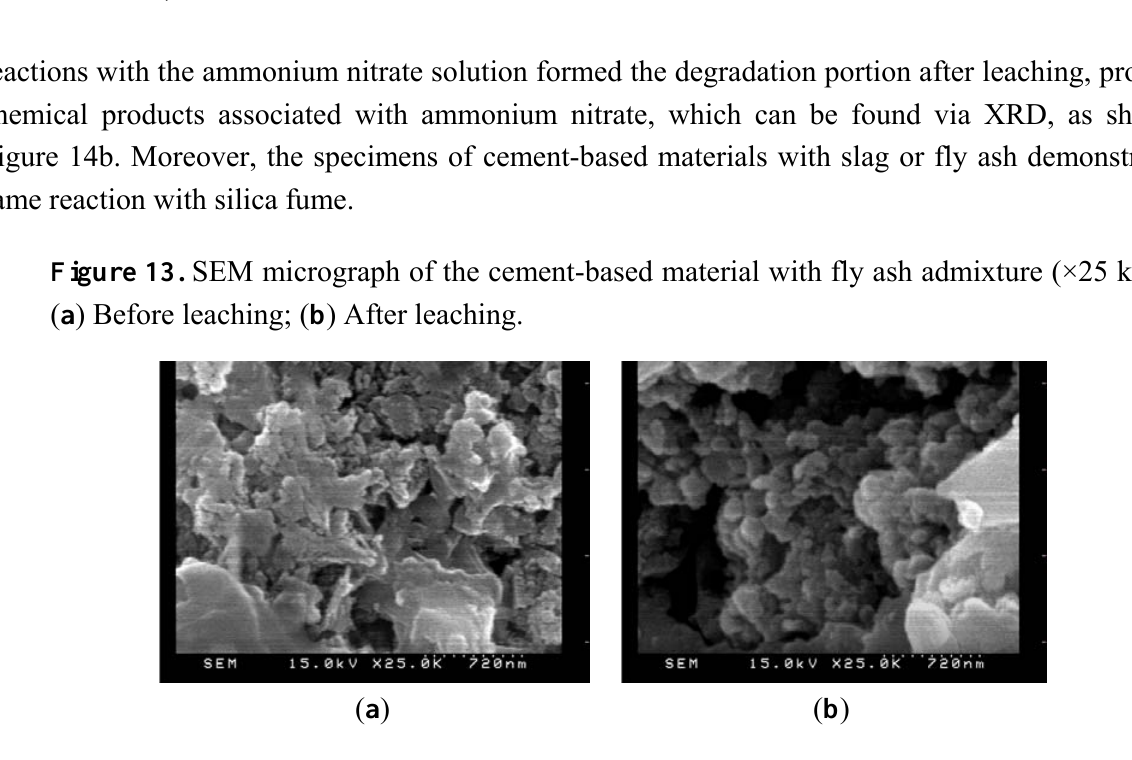
Figure 14. XRD results of specimens with silica fume admixture: ( a ) Prior to leaching; ( b ) After